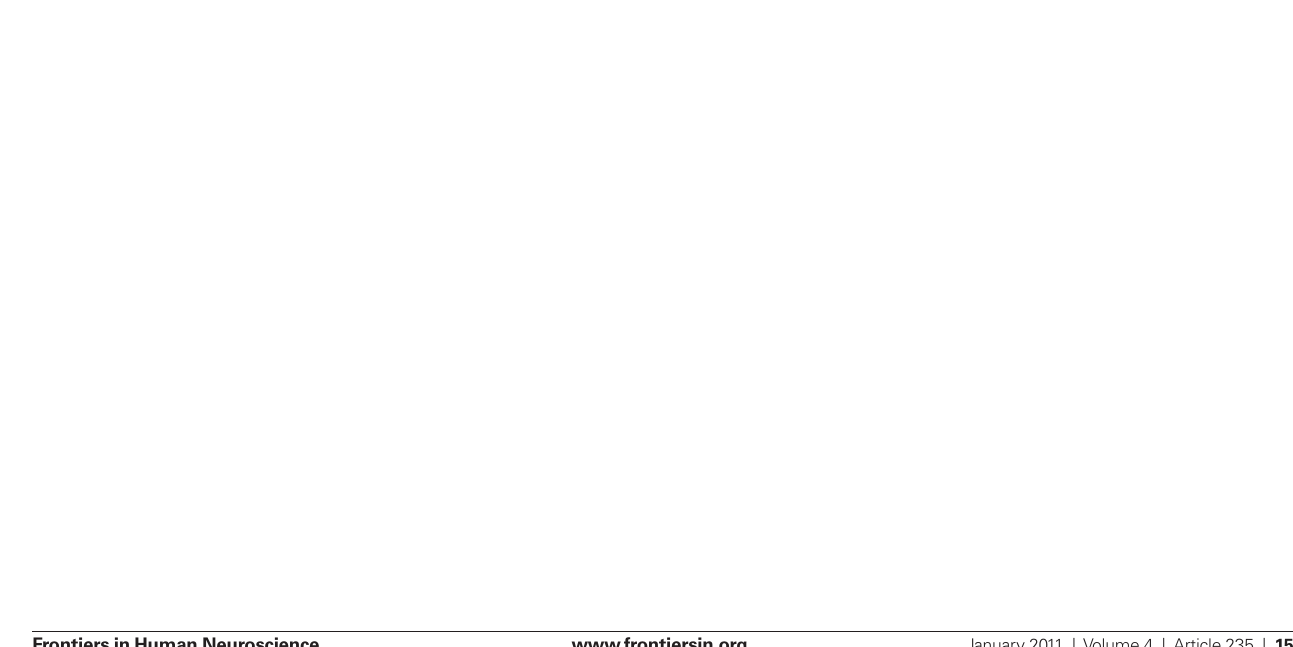
FiGurE A1 | DTT for each participant playing the Experimental Condition. The dashed green zone represents the absence of positive change in expectations in actual trial compared to previous trial, and is present for all 19 subjects of the experimental condition